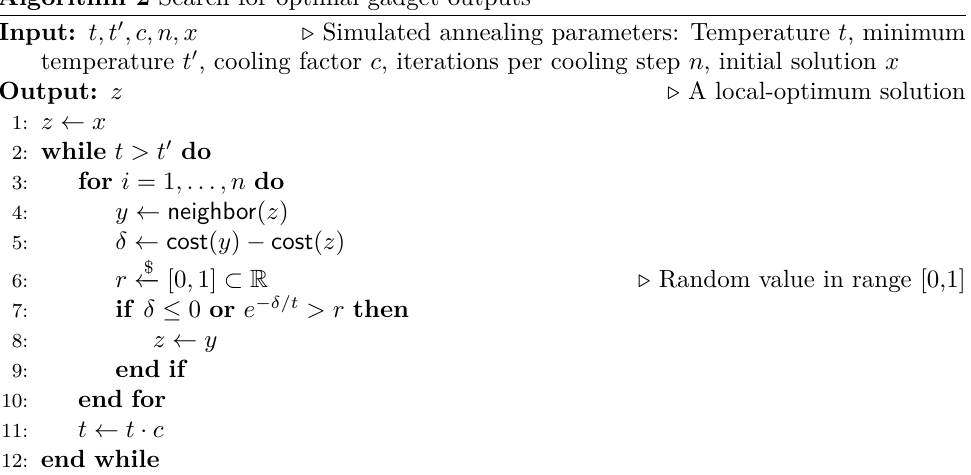
Algorithm 2 Search for optimal gadget outputs